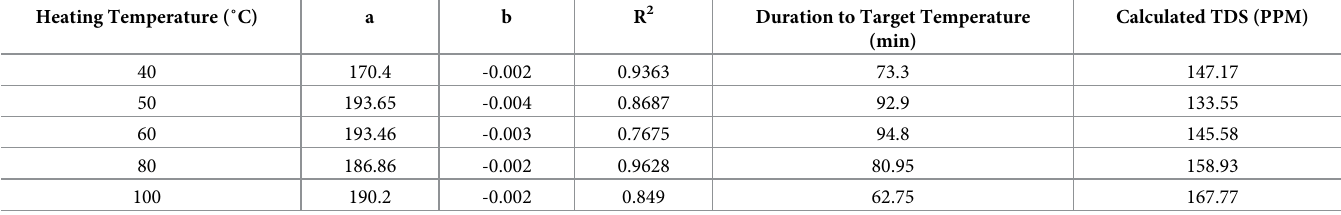
Table 2. Calculated TDS measurements at